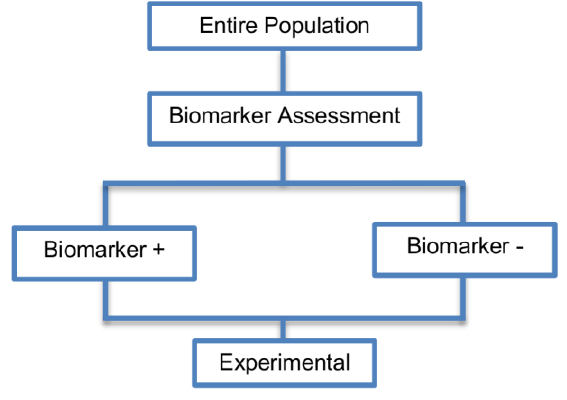
Figure 2. Single arm designs.